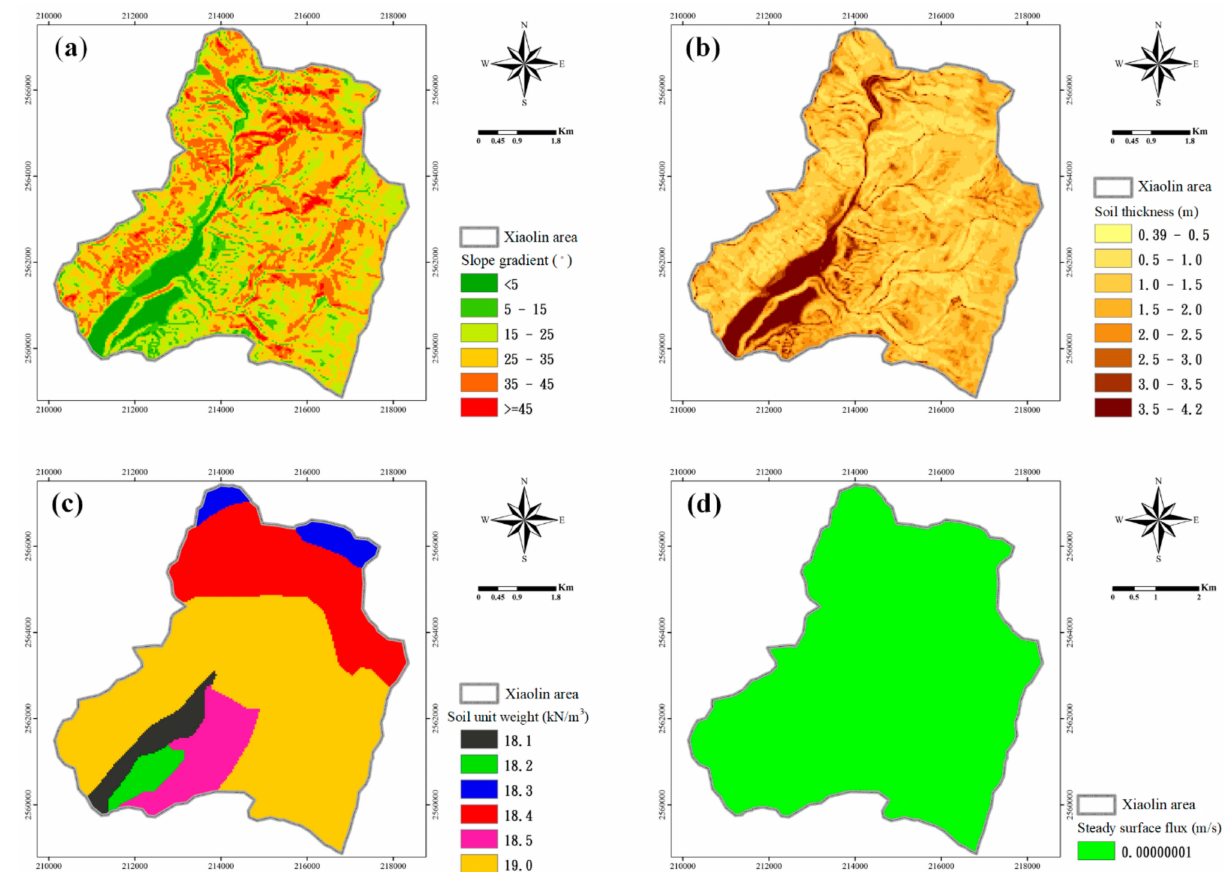
Figure 5. Required fundamental parameter layers for the Transient Rainfall Infiltration and Grid-based Regional Slope- Stability (TRIGRS) model: ( a ) Slope gradient; ( b ) Soil thickness; ( c ) Saturated soil unit weight; ( d ) Initial steady surface